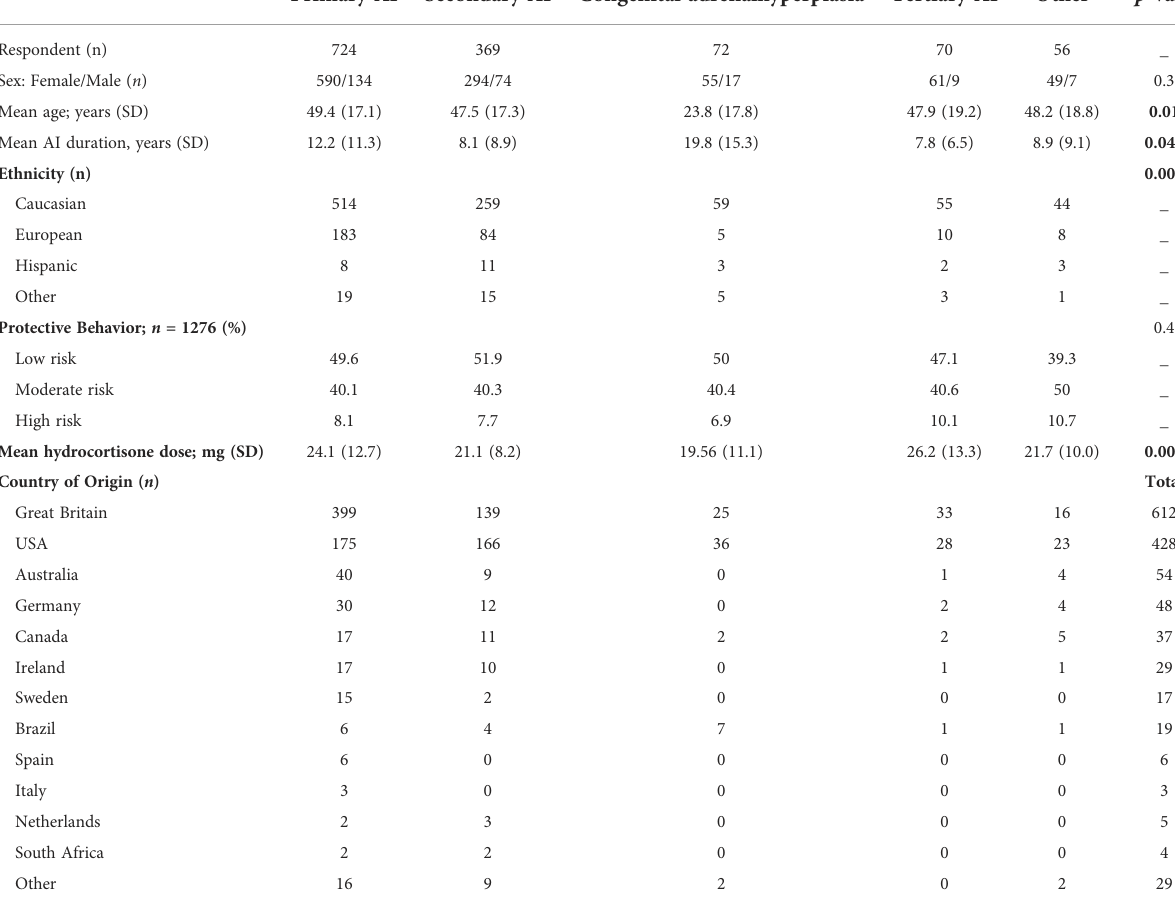
TABLE 1 Baseline demographic characteristics of responders (* p -value < 0.05 considered signi fi